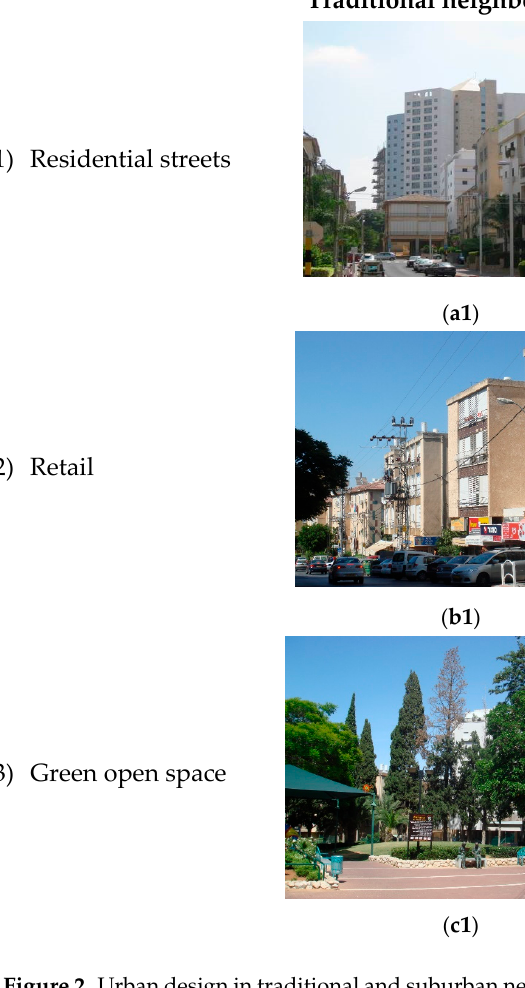
Figure 2. Urban design in traditional and suburban neighborhoods ( a1 ) residential street in a traditional neighborhood, ( a2 ) residential street in a suburban neighborhood, ( b1 ) retail street in a traditional neighborhood, ( b2 ) a mall in a suburban neighborhood, ( c1 ) green open space in a traditional neighborhood, ( c2 ) green open space in a suburban neighborhood.